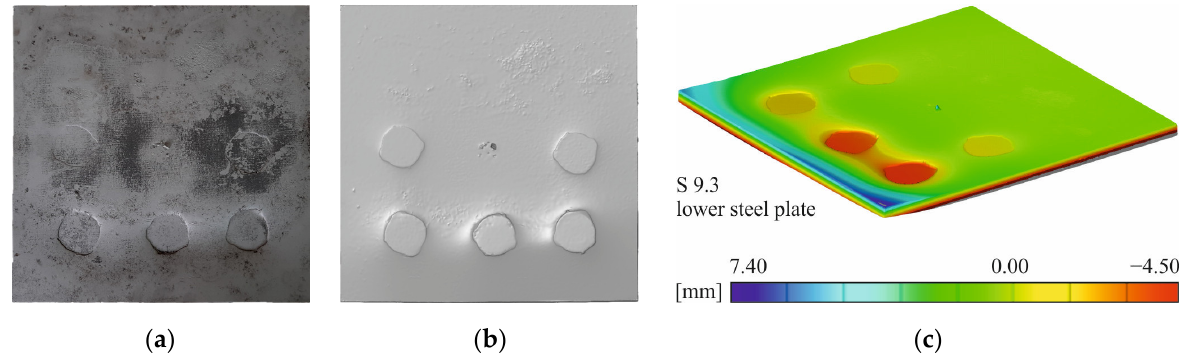
Figure 6. Lower steel plate of component test S 9.3: ( a ) photography; ( b ) 3D laser scan; ( c ) measured deformations.